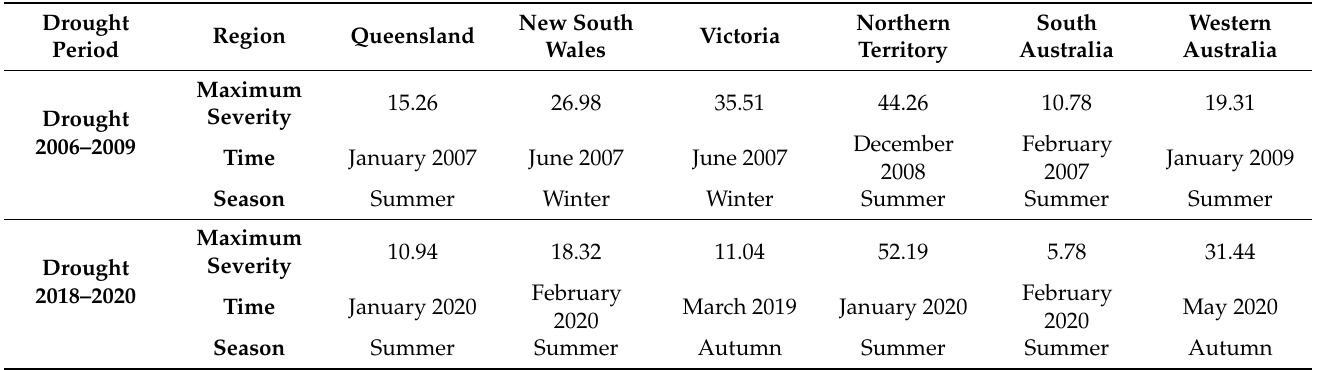
Table 4. Maximum drought severity of each region and its corresponding time (unit: cm